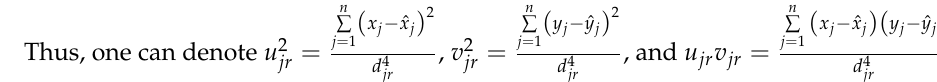
Figure 3. Geometric representation of the distance between the Target’s position and Base station.